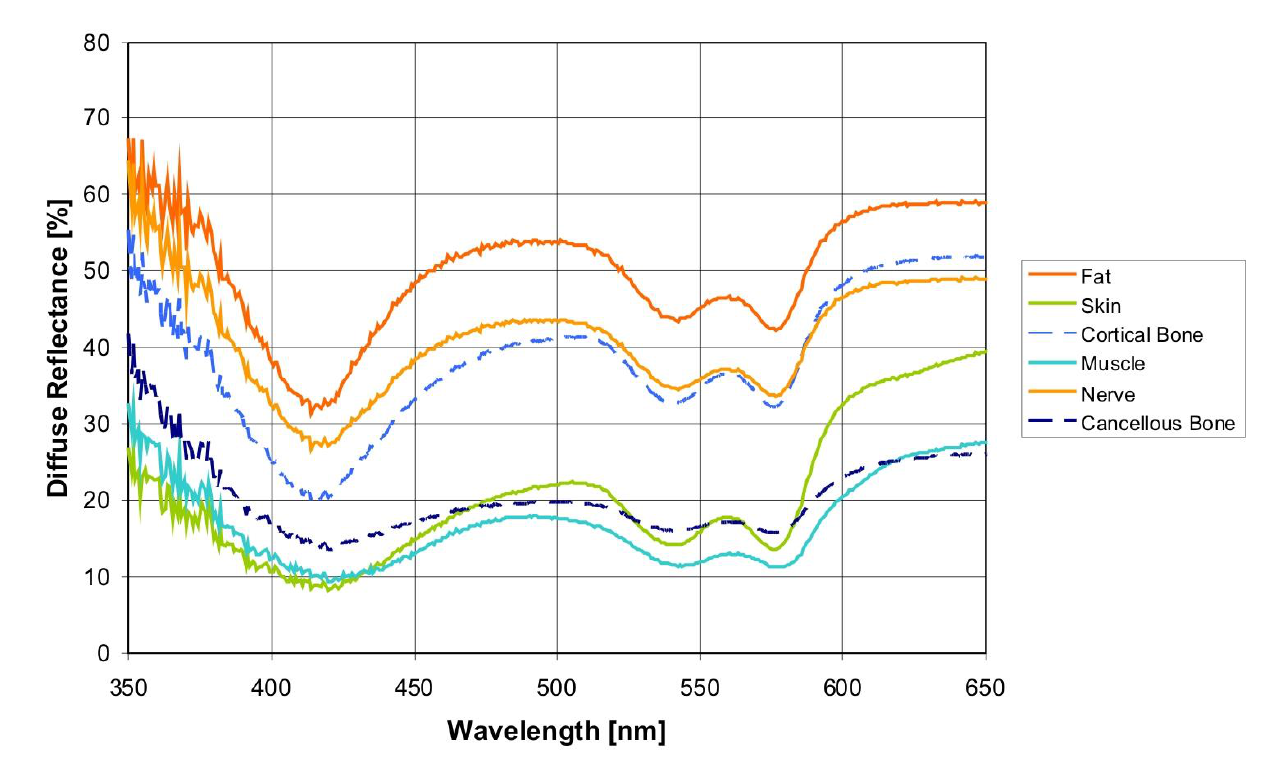
Figure 4. Diffuse reflectance spectra for different hard and soft tissues measured during laser ablation (averaged over 900 measurements per tissue type), spectrometer QE 65000.